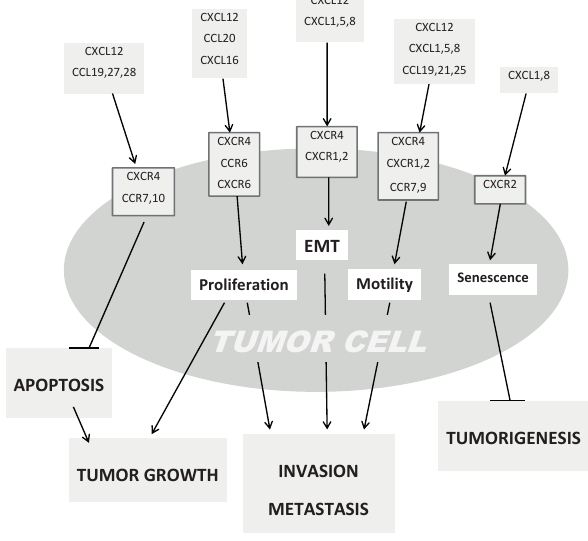
Fig. 2. Effects of chemokines on tumor cells. Whereas most chemokines activating cancer cell chemokine receptors promote proliferative and invasive properties of can- cer cells, specific CXCR2-binding chemokines can promote the arrest of cellular growth by inducing cellular senescence and delay the early phase of tumorigenesis. (EMT = epithelial-mes- enchymal transition). Adapted from Mukaida et al., 2014 (ref. 7